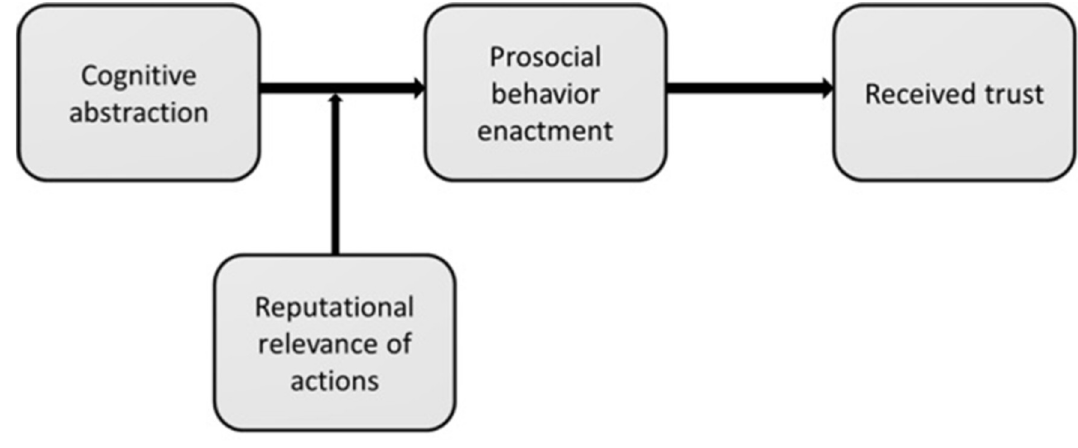
Fig 1. Theoretical